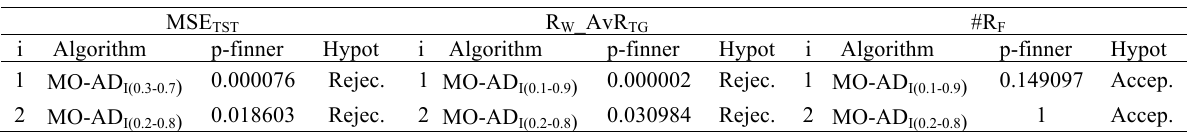
Table A.7 Finner Table with α = 0.05 for the methods on MSE TST , R W _AvR TG and #R F on MAX ACC point using WM rule bases.